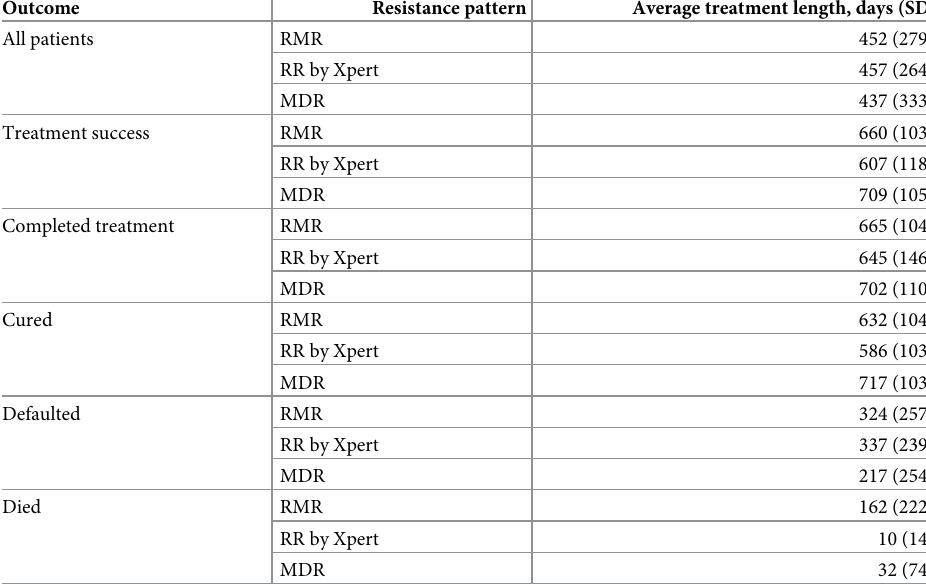
Table 4. Treatment length by resistance pattern